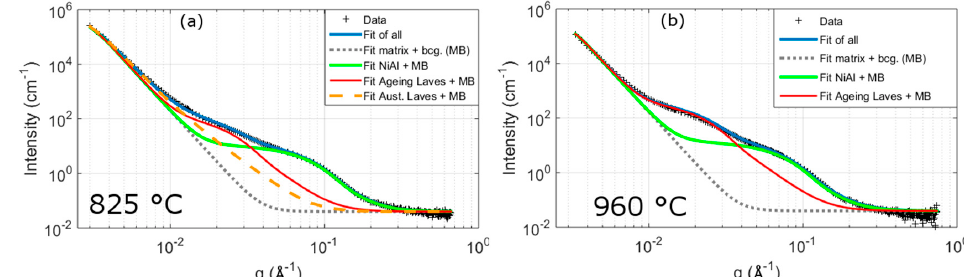
Figure 5. Example fits to the SANS (Small angle neutron scatterin) data after ageing at 540 °C for 7.5 h. Fits to the data with ( a ): the an initial 825 °C austenitisation treatment and ( b ): after austenitisation at 960 °C. The fits to the different components are added to the matrix plus background contribution (MB).